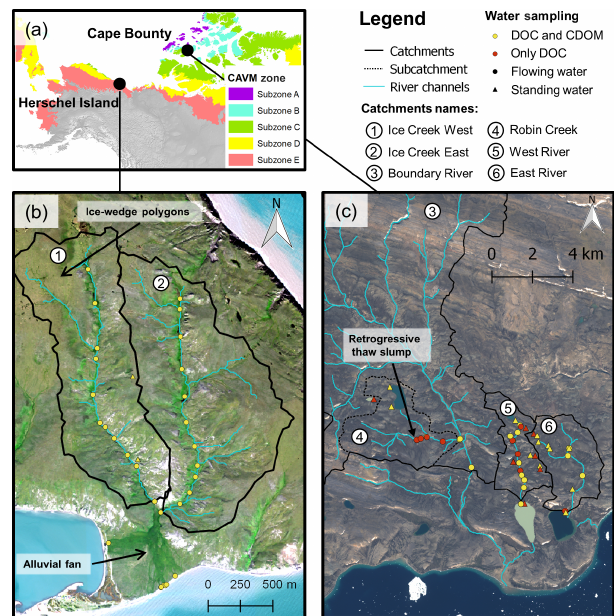
Figure 1. Maps of the study area showing (a) the location of Her- schel Island and Cape Bounty in the Canadian Arctic including the Circumpolar Arctic Vegetation Map (CAVM) bioclimatic zones (CAVM, 2003), (b) the studied catchments Ice Creek West and Ice Creek East on Herschel Island, and (c) the studied catchments Boundary River with its subcatchment Robin Creek (dashed water- shed), West River, and East River. The watershed names are indi- cated with numbers, and the general flow direction is southwards towards the ocean. Note that samples from flowing water (rivers and streams) are indicated by circles, whereas samples from stand- ing water (ponds and lakes) are indicated by triangles. Yellow marks locations where DOC concentration and cDOM measurements are available, while only DOC concentrations are available at red loca- tions. The basemap for (a) is the World Hillshade layer by Esri (cre- ated 2015, last updated 2019). The background images for (b) and (c) are true colour mosaics (Herschel Island: WorldView-3 quasi- true colour RGB composite, acquired on 8 August 2015; Cape Bounty: Sentinel-2 quasi-true colour RGB composite, acquired on 7 August